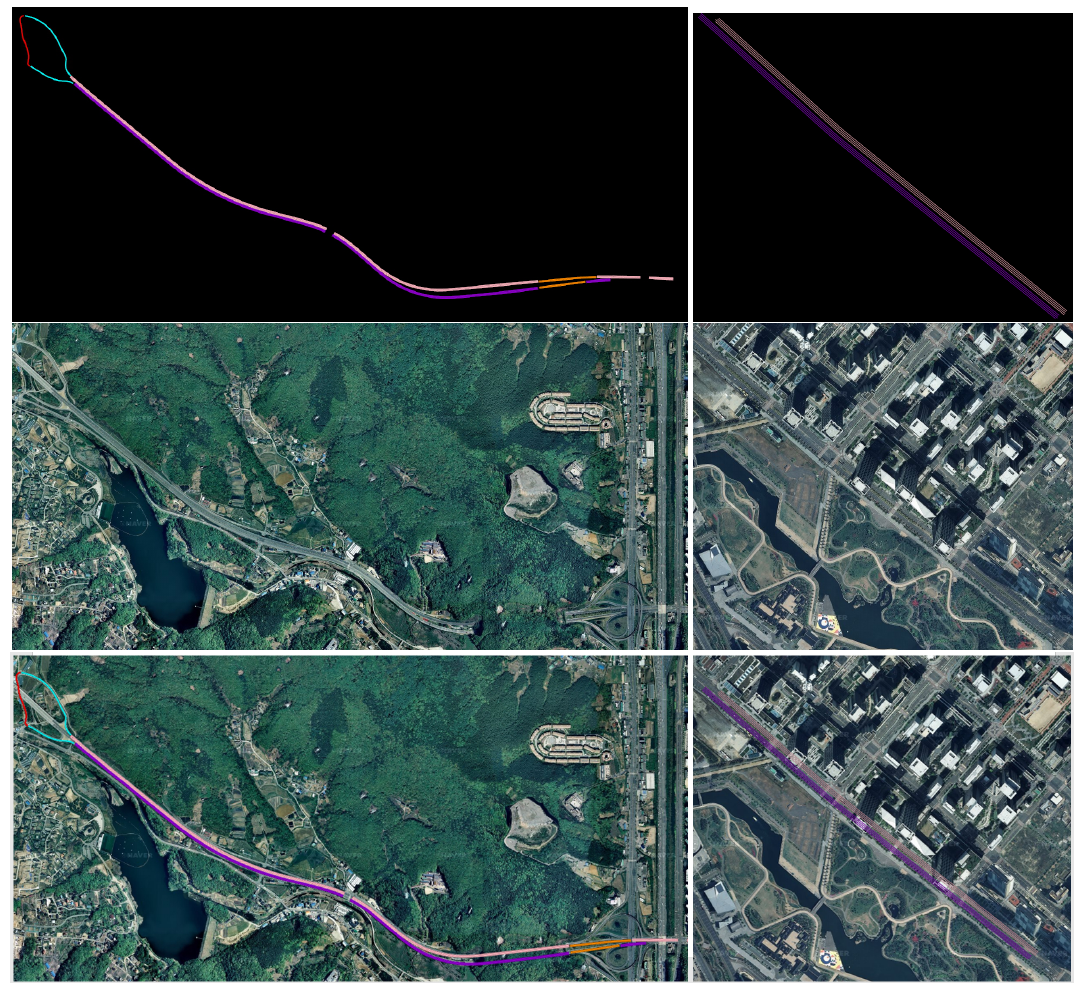
Figure 4. Result of the lane-level digital map and the corresponding satellite images of Route 1 ( left ) and Route 2 ( right ). Magnified views are provided